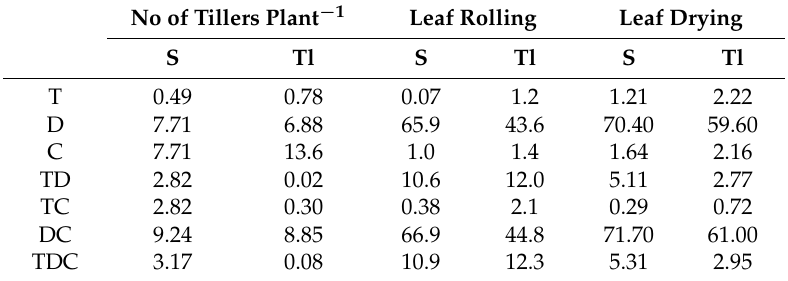
Table 2. Percentage of explanation (obtained through the coefficient of determination (R 2 ) from simple linear regression analysis) of temperature (T), drought (D), cultivar (C), and their combinations on numbers of tillers plant − 1 , leaf rolling, and leaf drying at the seedling (S) and tillering (Tl) stages. No of Tillers Plant − 1 Leaf Rolling Leaf